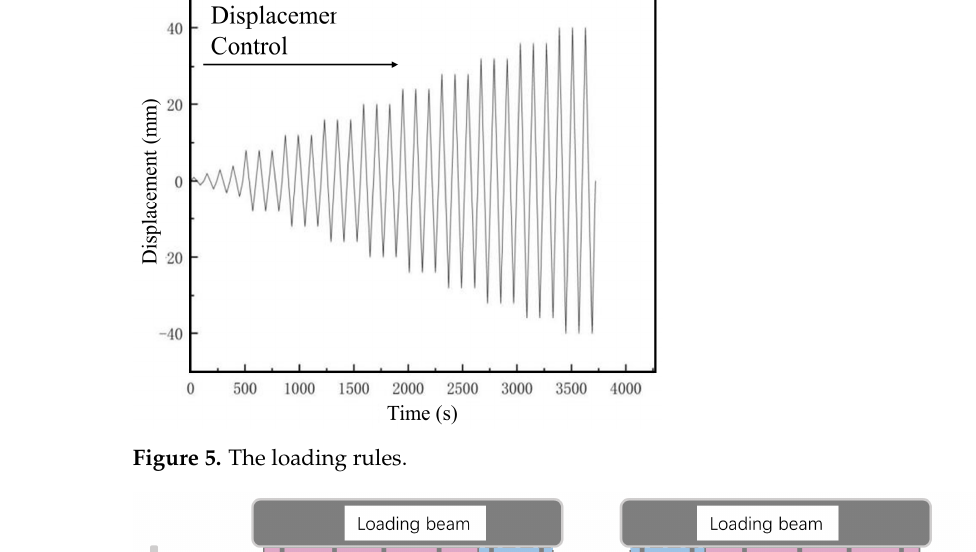
Figure 5. The loading rules.